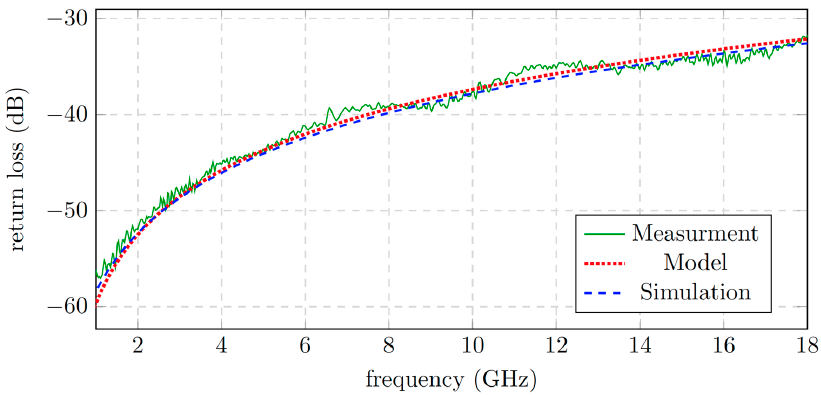
Figure 16. Return loss: Measurement vs. Model vs. Simulation.